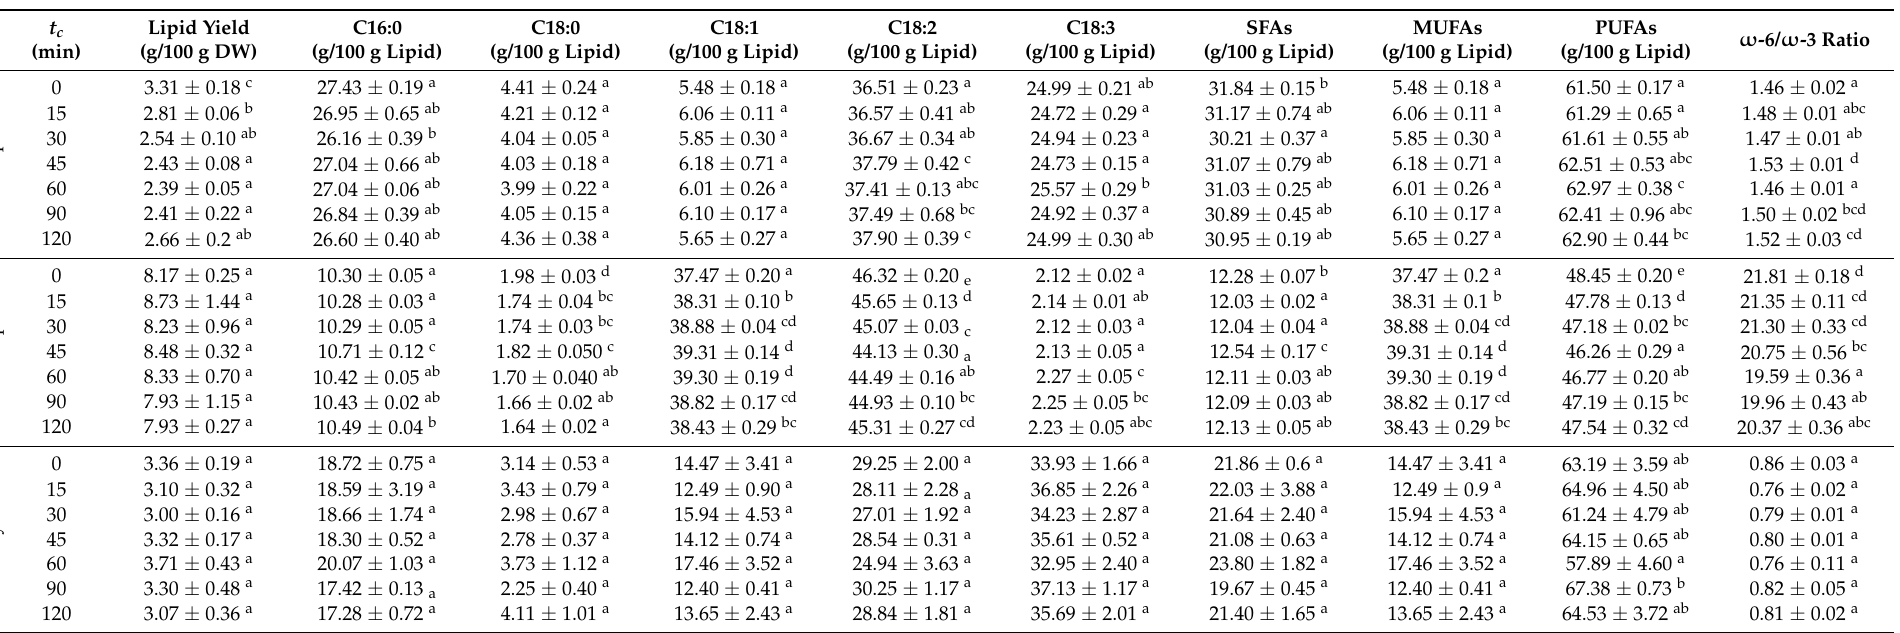
Table 1. Lipid yield and relative fatty acid abundance (g/100 g lipid extract) of (cooked) cowpeas, chickpeas and kidney beans as affected by hydrothermal processing at varying